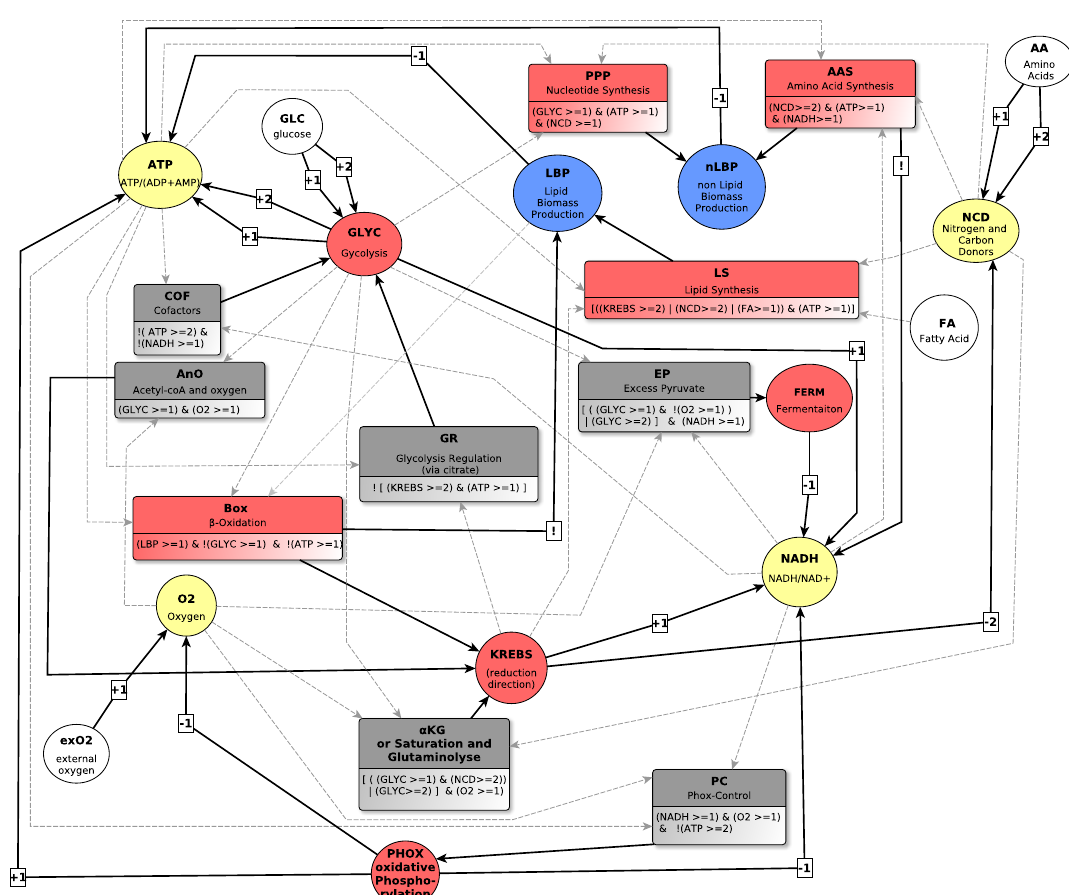
Figure 3. Influence graph of the regulation of cell metabolism. Circles represent variables whereas rectangles represent